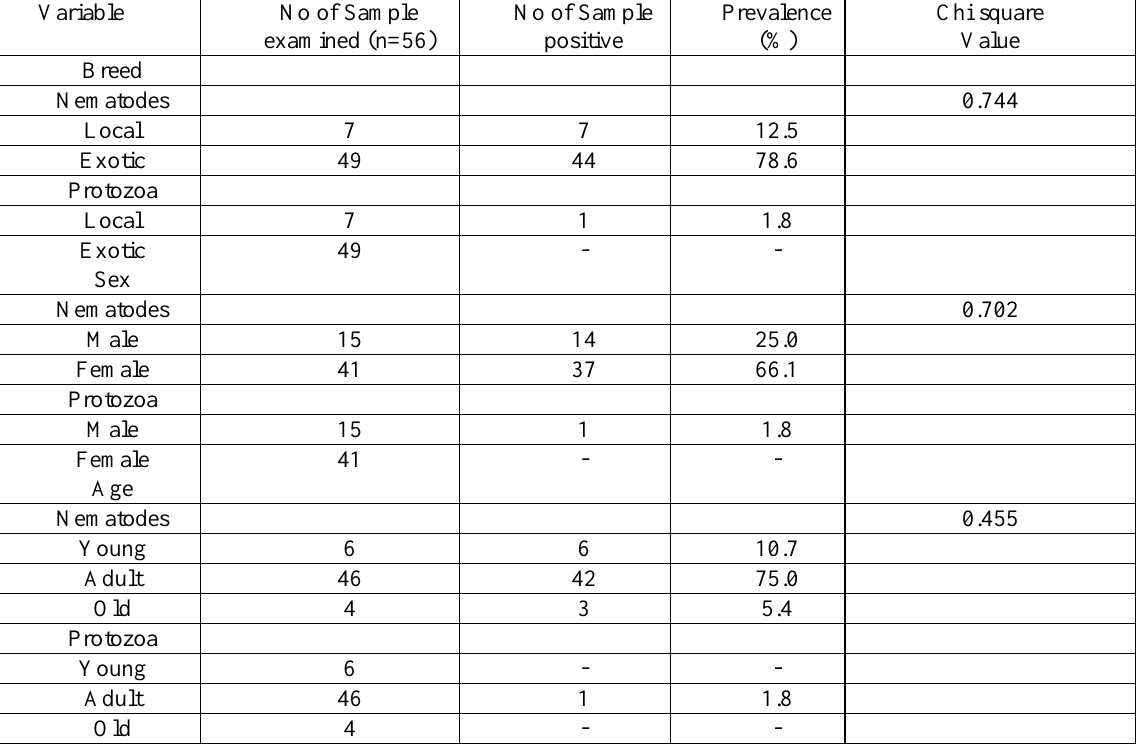
Table 2. Prevalence of Nematodes and Protozoa in relation to predisposing factors of horses: Variable